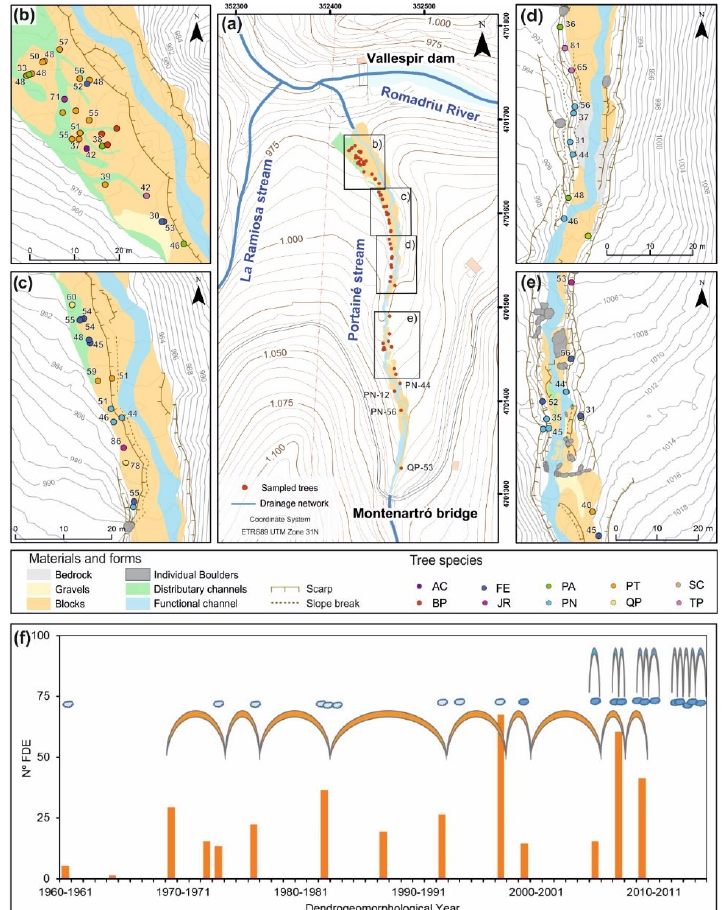
Figure 12. ( a ) Geomorphic forms at the Portainé cone and location of the 67 sampled trees. Black boxes show the stream stretches enlarged in ( b ), ( c ), ( d ), and ( e ) that show the main geomorphic forms and materials as well as the sampled trees, with the species indicated by colours and the estimated age by numbers. In the southern part of the study area, the scattered trees are identified with the species code and the estimated age. Species code: AC— Acer campestre L., BP— Betula s.p. L., FE— Fraxinus excelsior L., JR— Juglans regia Liebl., SC— Salix caprea L., TP— Tilia platyphyllos Mill. ( f ). Number of dated FDE (columns in orange) and documented events of regional (light blue clouds) or local (dark blue clouds) rainfalls. The arcs represent the well-defined event-to-event intervals determined by the Flood Dendrogeomorphological Evidence (arcs in orange colour) and by the documented local events rainfalls since 2006 in the Portain é stream (arcs in grey